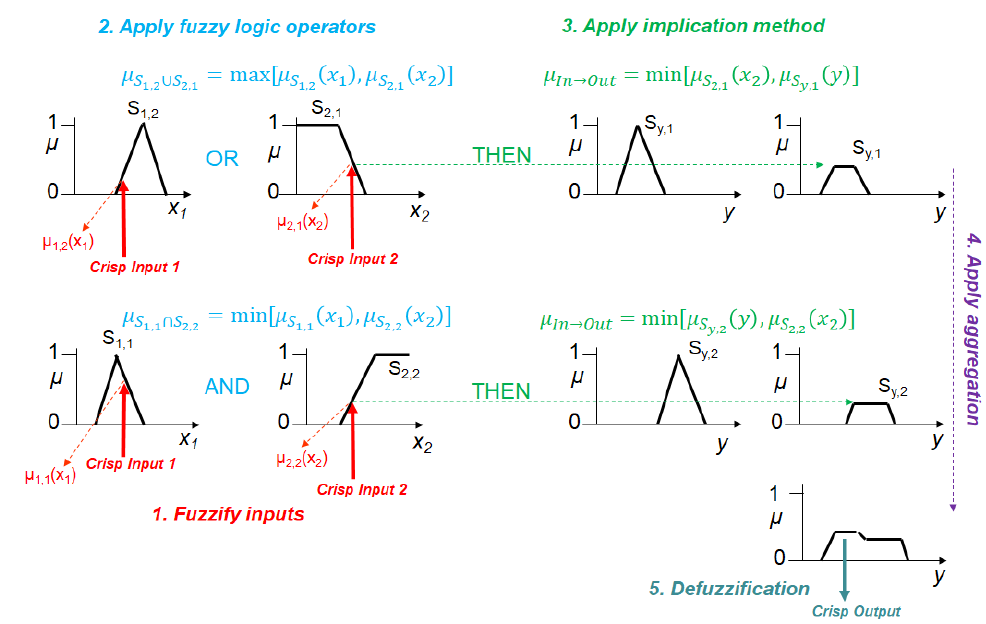
Figure 3. The flow of information in a fuzzy logic system where AND, OR and the implication have been implemented through the minimum, the maximum, and the minimum operators, respectively.